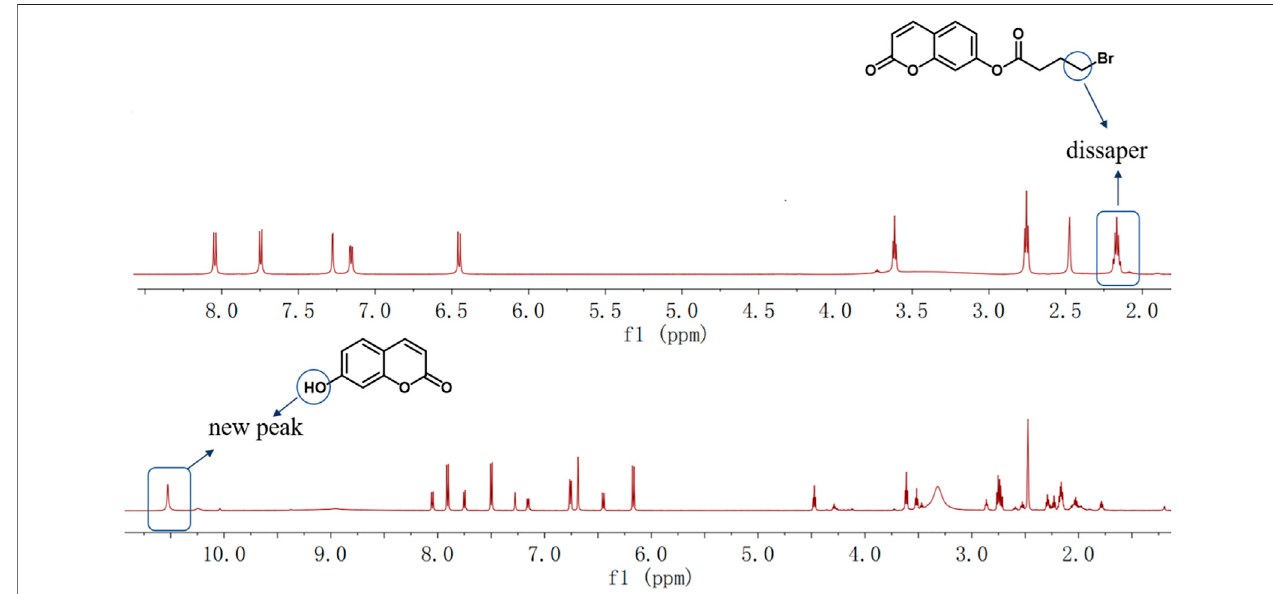
FIGURE 4 | 1 H NMR spectra of OCYB before and after adding N 2 H 4 .